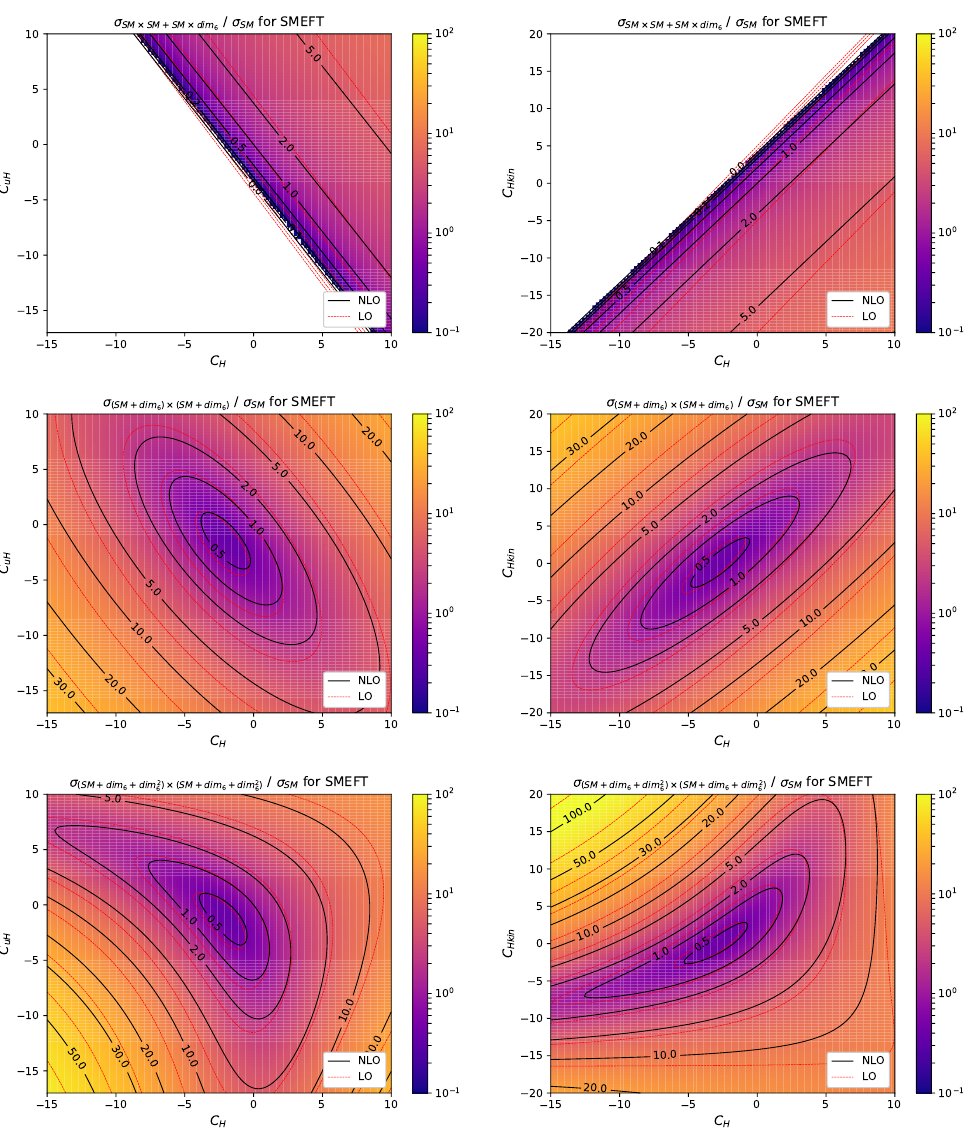
Figure 1 . Heat maps showing the dependence of the cross section on the couplings C H , C uH (left) and C , C (right) with Λ = 1 TeV for different truncation options. Top: option (a) H H, kin (linear dim-6), middle: option (b) (quadratic dim-6), bottom: option (d) (no linearisation in 1 / Λ ). The white areas denote regions in parameter space where the corresponding cross section would be